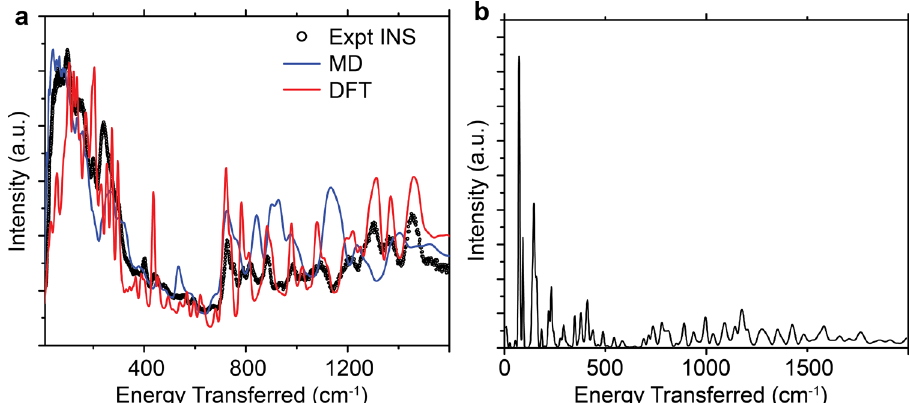
Figure 3. ( a ) Comparison between experimental INS spectrum, DFT simulated spectrum, and MD simulated spectrum. The MD spectrum was convolved by a Gaussian of width 0.01E, where E is the energy transfer. ( b ) The INS spectrum calculated from the normal modes of a supercell of the DFT structure using the MD forcefield is also plotted.